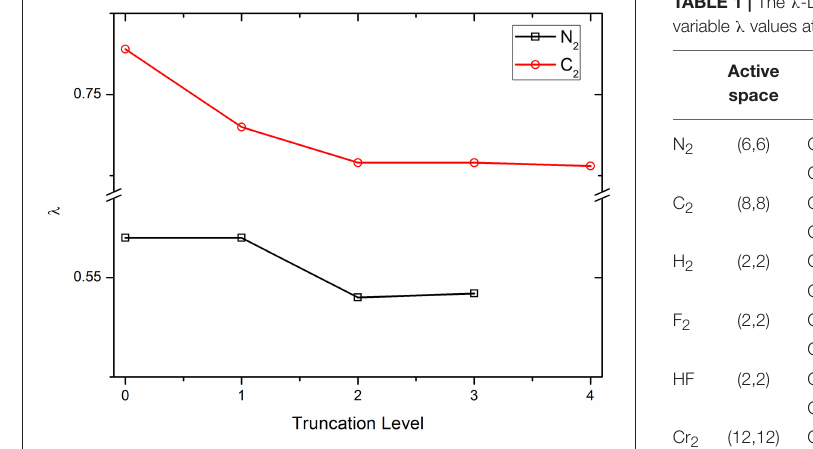
FIGURE 1 | The λ values for N 2 and C 2 with various truncation levels of VB wave function.